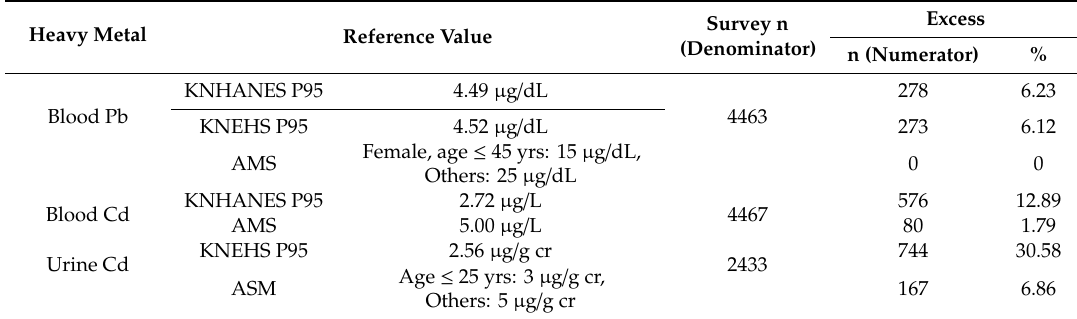
Table 5. Proportion of excess subjects with respect to heavy metal